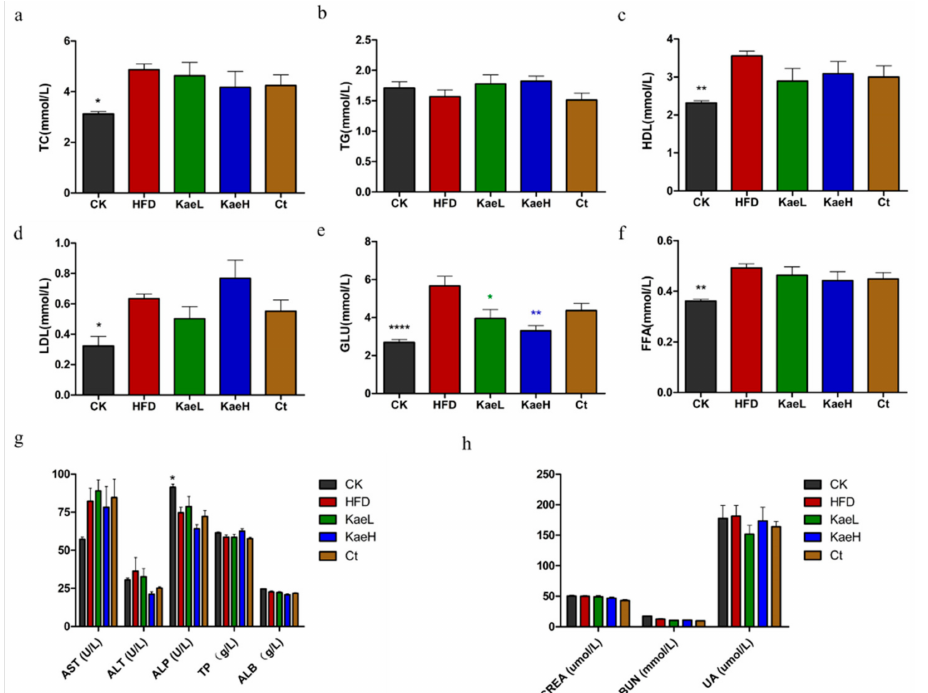
Figure 3. Effects of C. tinctoria and kaempferol on biochemical parameters of serum. ( a ) TC. ( b ) TG. ( c ) HDL. ( d ) LDL. ( e ) GLU. ( f ) FFA. ( g ) Liver function parameters. ( h ) Kidney function